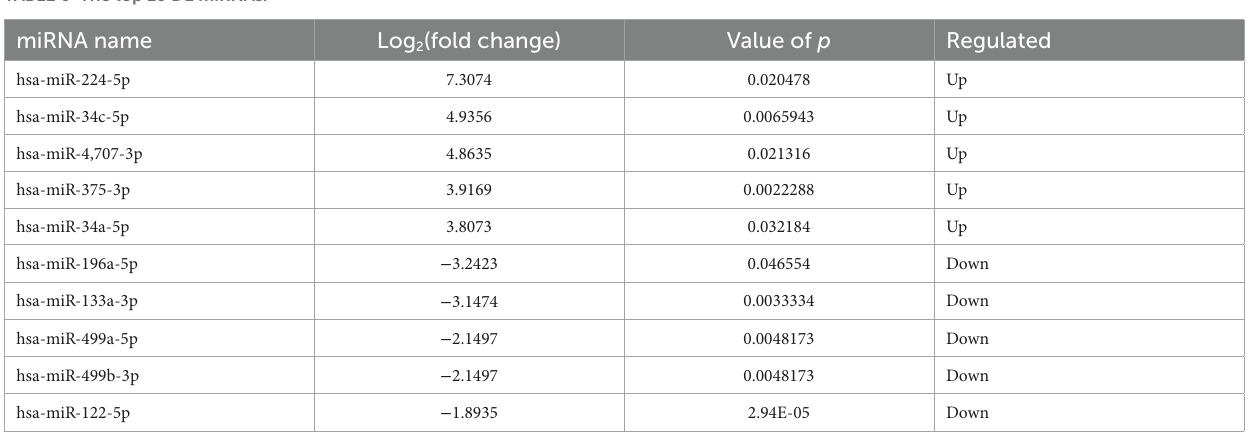
TABLE 6 The top 10 DE